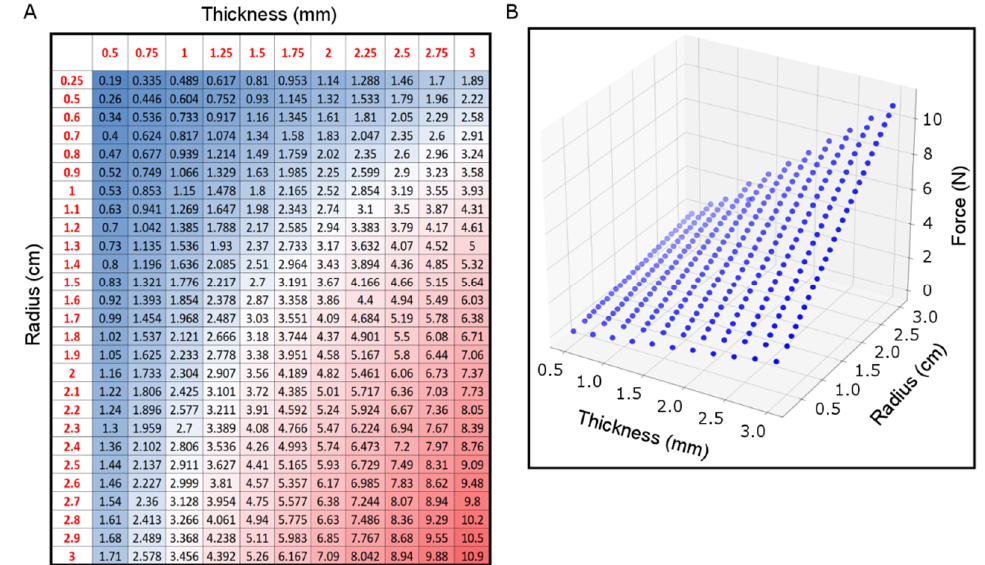
Figure 8. Predicted required mechanical force for different geometrical metrics (radius and thickness) of small intestine for human subjects. ( A ) Heat map and ( B ) Regular 3D plot.